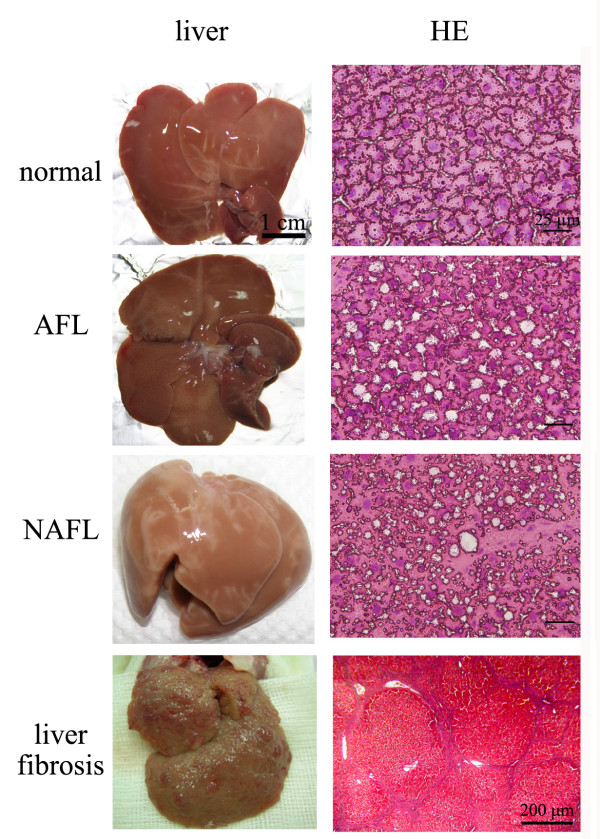
Histological analysis and comparisons among four groups of rats. Images of livers from normal control, rats with alcoholic fatty liver (AFL), non-alcoholic fatty liver (NAFL, fed 60% fructose) and liver fibrosis (left column) were analyzed by hematoxylin and eosin (H&E) staining (right column). In AFL and NAFL rats, livers were filled with prominent fatty change. The scale bar represents 25 μm for normal, AFL and NAFL; but 100 μm for liver fibrosis.